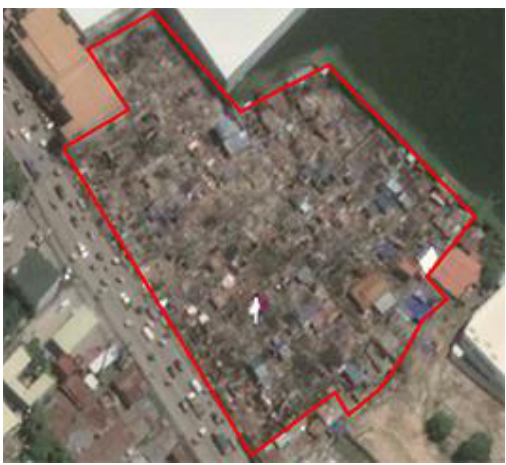
Figure 10: Tamiya, Barangay Basak, Lapu-lapu City (post- fire, extent outlined in red)